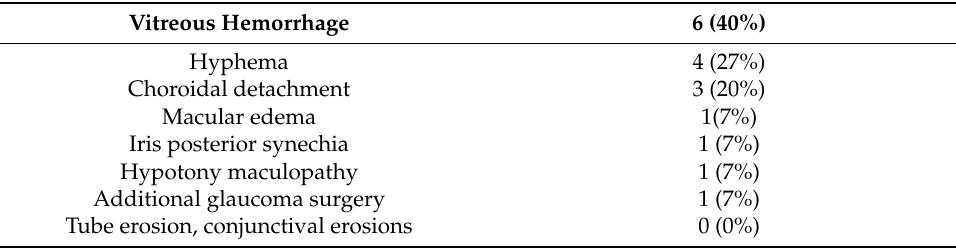
Table 2. The postoperative